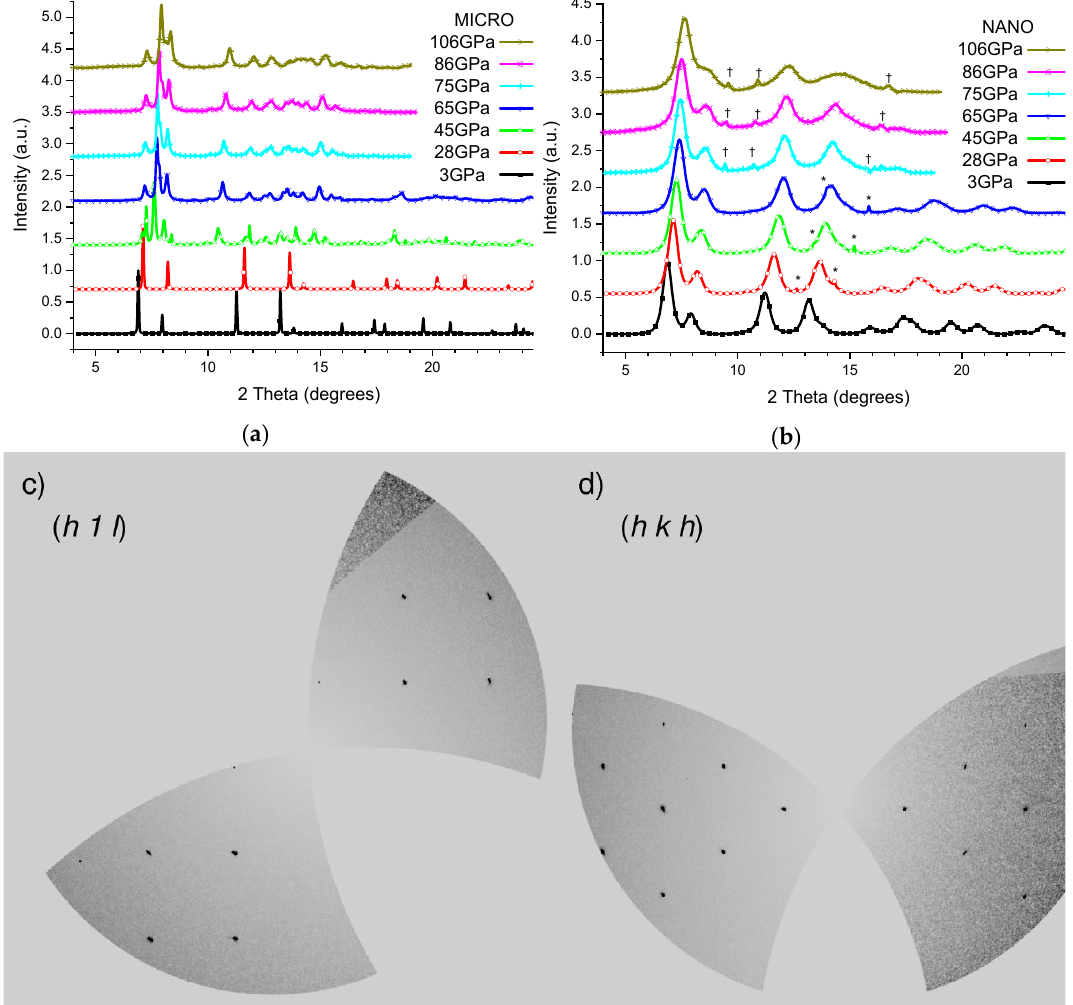
Figure 1. X-ray diffraction patterns for different pressure of MICRO ( a ) and NANO ( b ) CeO 2 , symbols * and † represent reflections from Helium and Rhenium, respectively. ( c ) and ( d ) show reciprocal space reconstructions of (h1l) and (hkh) layers, respectively, of the single-crystal at 10 GPa.